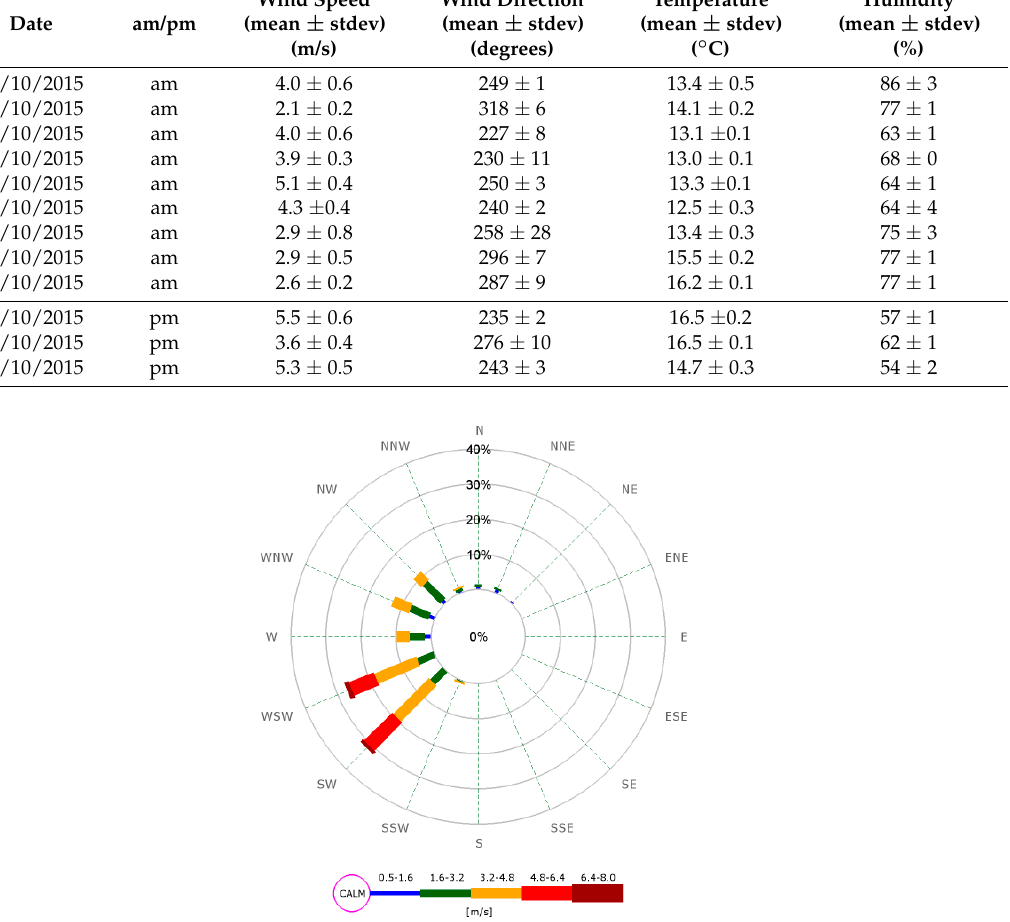
Table 3. Complete route average UFP counts range from 6900 counts/cm 3 to 39,900 counts/cm 3